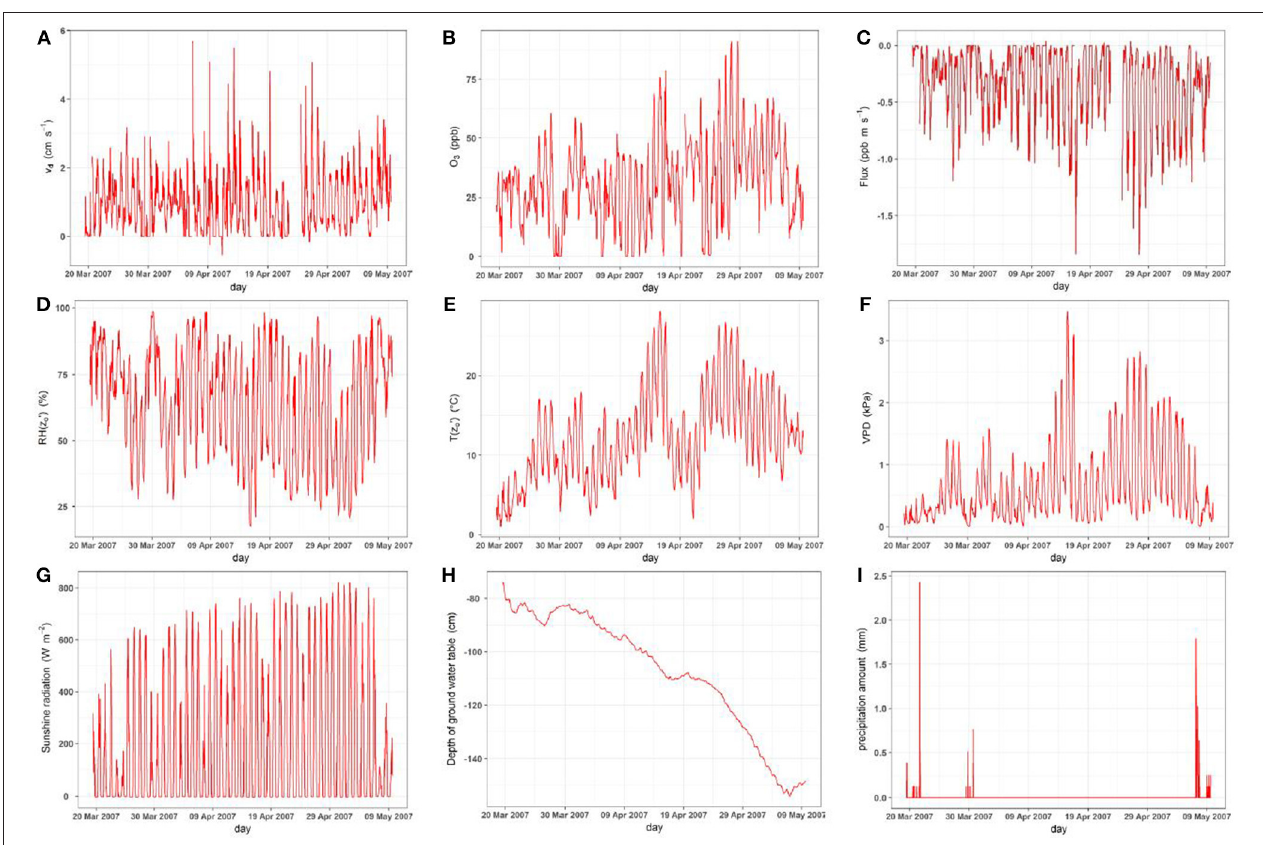
FIGURE 9 | Time series of half-hourly (A) deposition velocity ( υ d ), (B) ozone mixing ratio, (C) ozone flux ( F ), (D) relative humidity at the leaf surface ( RH (z 0 ′ )), (E) temperature at the leaf surface ( T (z 0 ′ ), (F) vapor pressure deficit ( VPD ), (G) solar radiation, (H) depth of ground water table, (I) precipitation sum over the period 20 March to 9 May